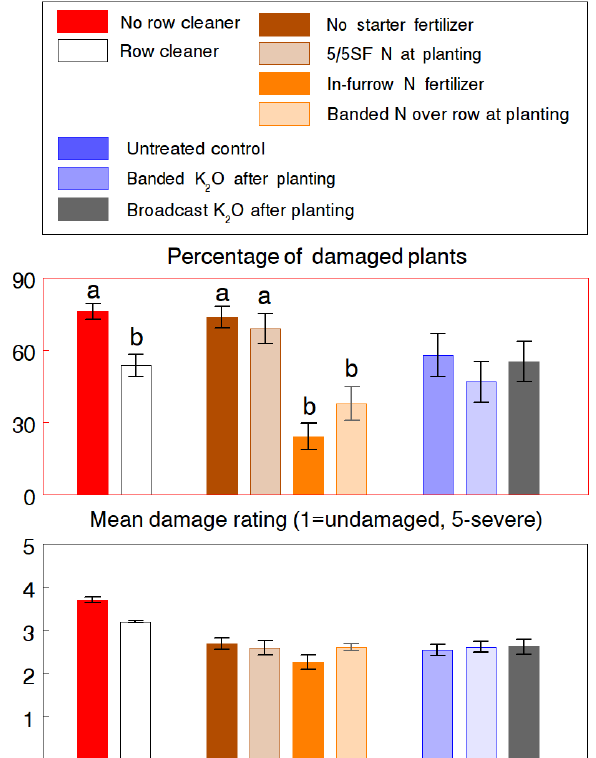
Figure 3. WREC experiment (1993). Effects of using row cleaner, different starter fertilizer practices, and dry granular potash treatments on damage caused of the gray garden slug, Deroceras reticulatum . Fertilizer treatments were: (1) 5/5SF of 30 kg N/ha of 34-0-0 applied at planting as a deep-band 5 cm to the side and 5 cm below the seed; (2) in-furrow application of ammonium nitrate at 10 kg N/ha; and (3) banded application of 25 kg/ha of ammonium nitrate over the closed seed slot. Application of potash at 120 kg K 2 O/ha was either banded over the seed row or broadcasted at the spike stage. Pairs of means ( ± SEM) of each of the three main effects with different letters are significantly different at the 5% probability level.